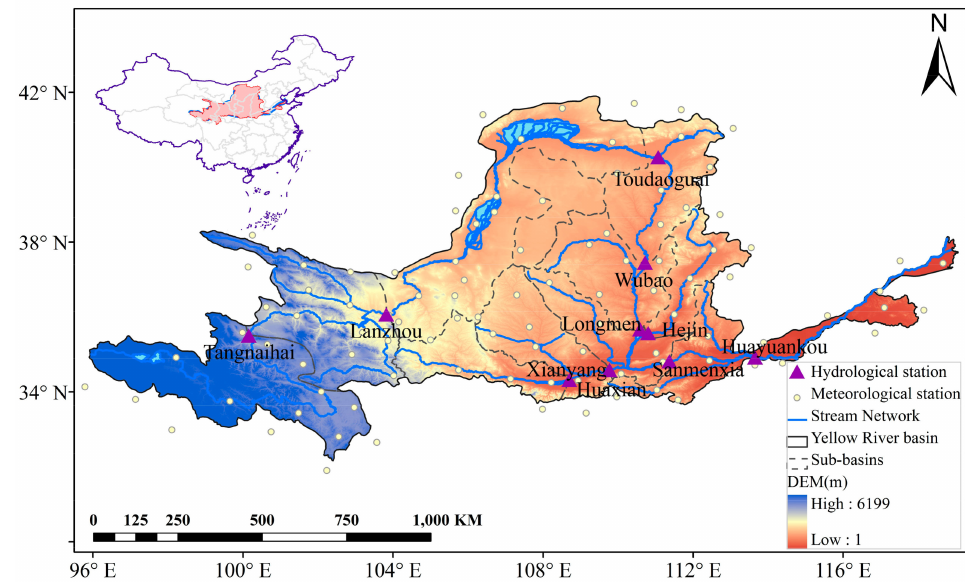
Figure 1. Locations of national meteorological stations, soil moisture observation sites and hydrological stations over